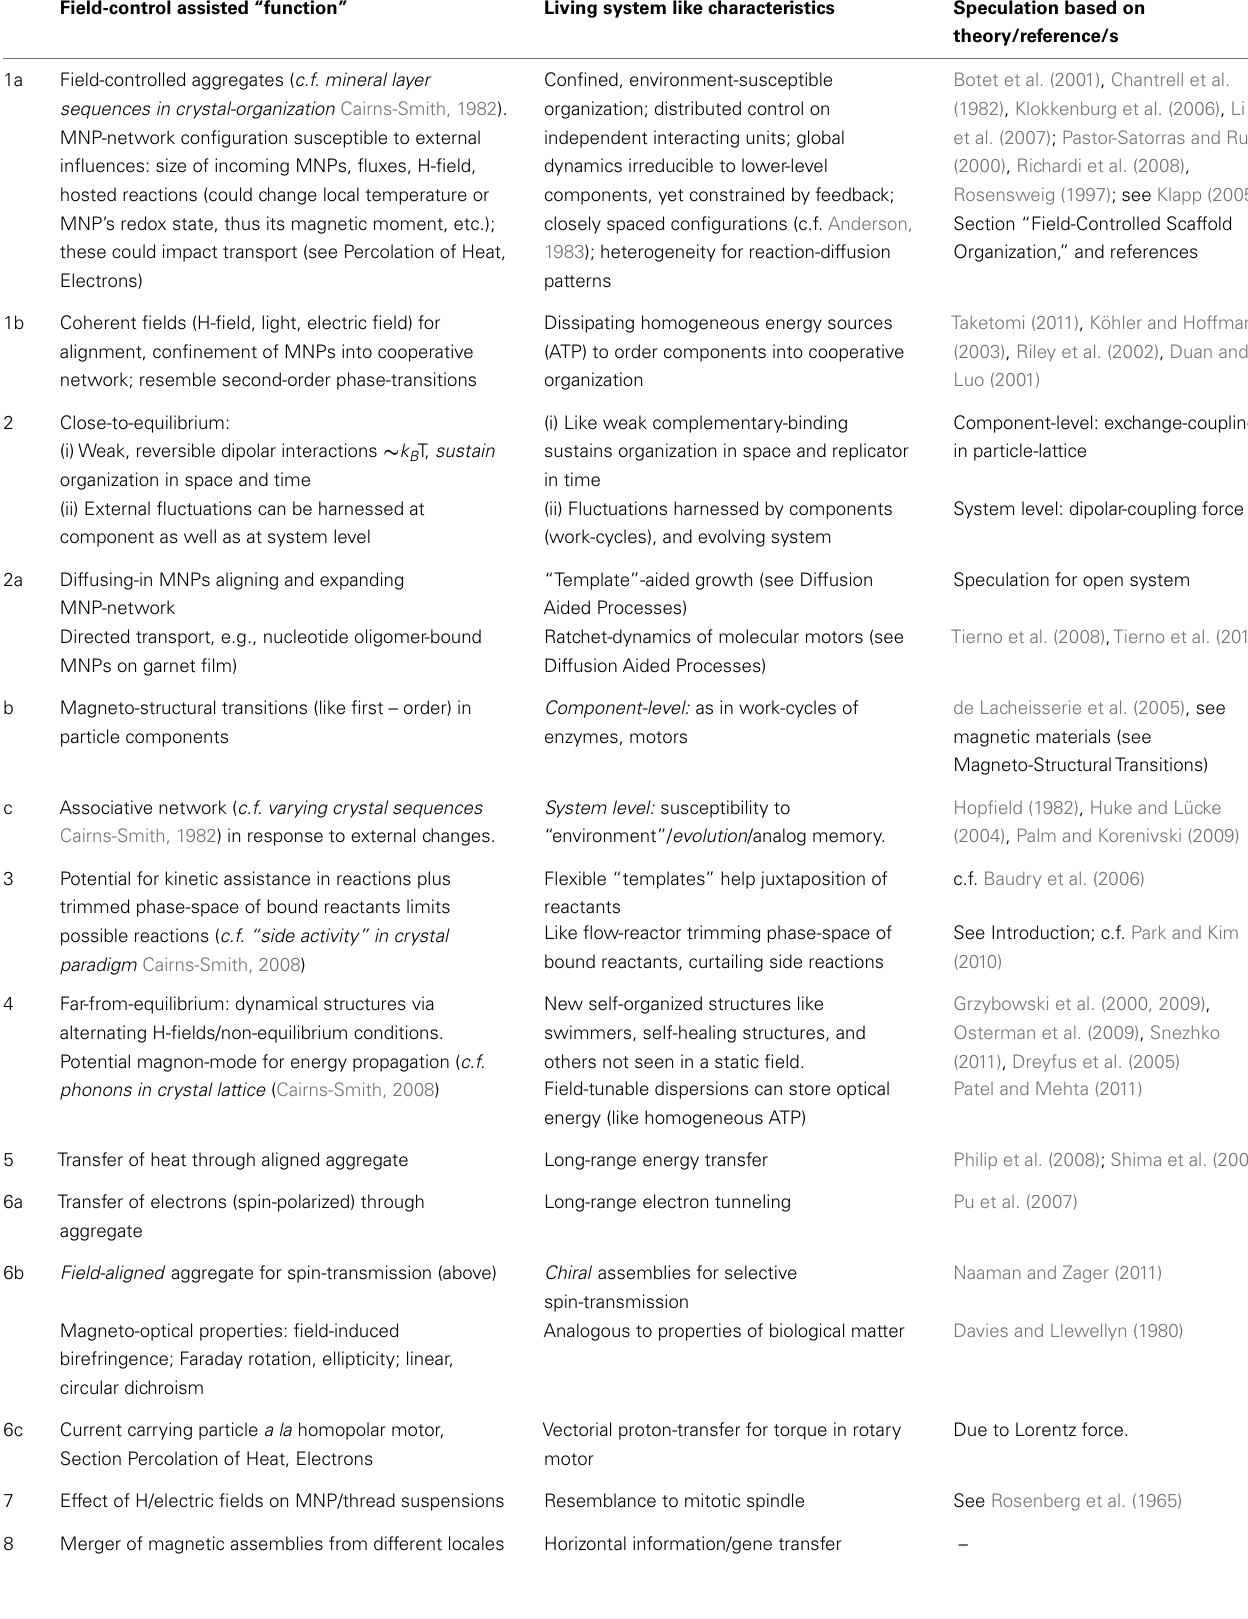
Table 2 | Field-controlled colloids for a “scaffold-organization” a la